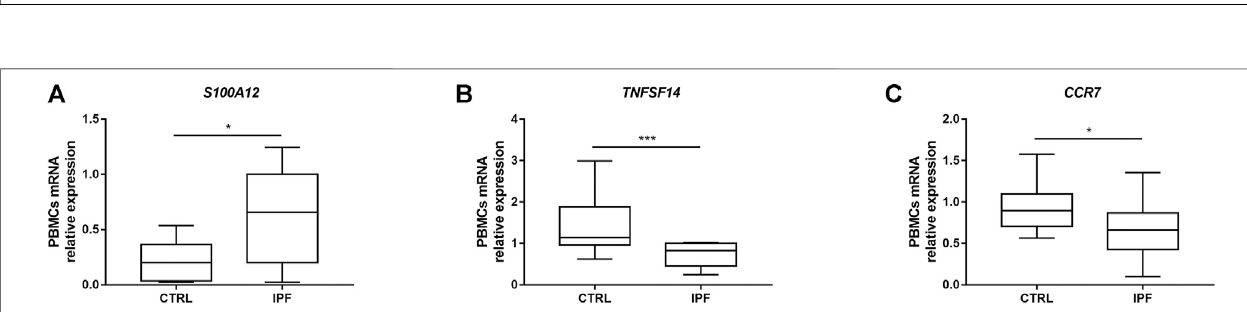
FIGURE5| Changesintheexpressionofthreeprognosticgenesintheperipheralbloodmononuclear cells(PBMCs) ofidiopathicpulmonary fi brosis(IPF)patients. Quantitative real-time polymerase chain reaction (qRT-PCR) was conducted to quantify the relative expression of the three prognostic genes in the PBMCs in healthy control (CTRL) ( n (cid:1) 16) and IPF ( n (cid:1) 14) patients. (A) SA100A12, (B) TNFSF4, and (C) CCR7. 18s RNA was used as an internal control gene. The data are presented as median with interquartile range (IQR) (Mann – Whitney test). *** p < 0.001, ** p < 0.01, and * p < 0.05 were considered statistically signi fi cant.